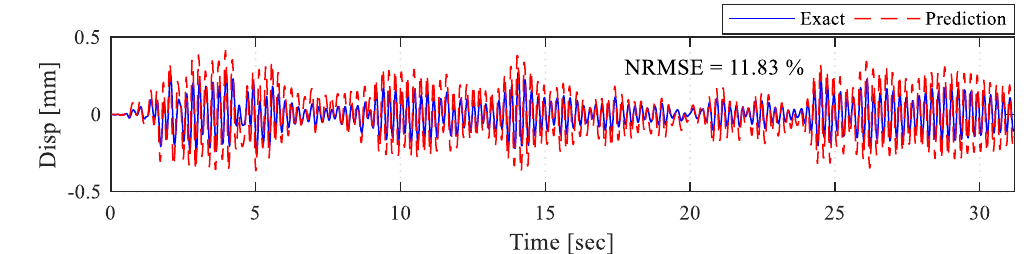
Figure 17. LSTM-predicted brace displacement input from Model 1b virtual HS compared to the exact analytical solution.